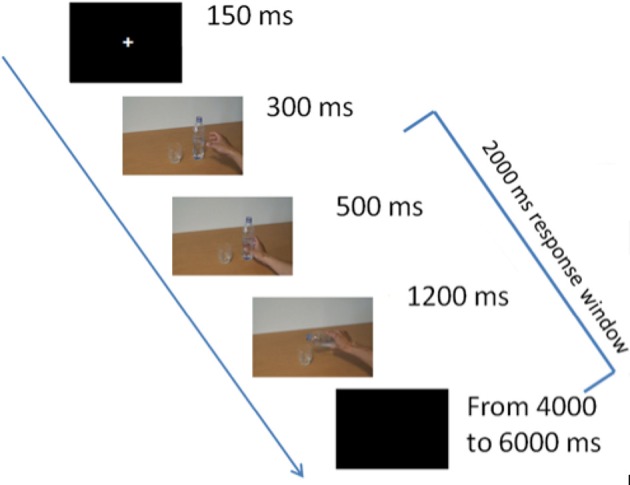
Experimental design. The first 300 ms-frame depicted the agent's right hand reaching one of two objects (e.g., a bottle of water) positioned on an empty table with neutral background. The second 500 ms-frame depicted the agent's right hand grasping that object. The third 1,200 ms-frame displayed the final intention (e.g., filling the glass of water). The three frames appeared immediately following each other, giving the visual illusion of a continuous video-clip. Finally, a 4,000–6,000 ms-inter-trial interval separated the onset of each video-clip presentation.